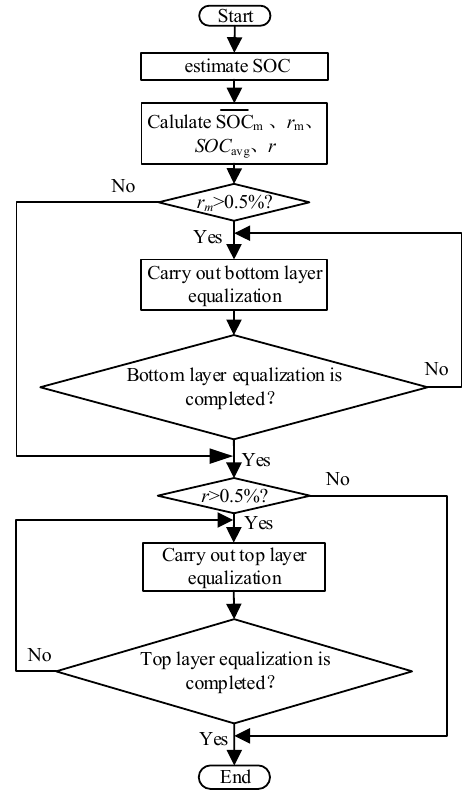
Figure 7. Flowchart of the proposed equalization algorithm.